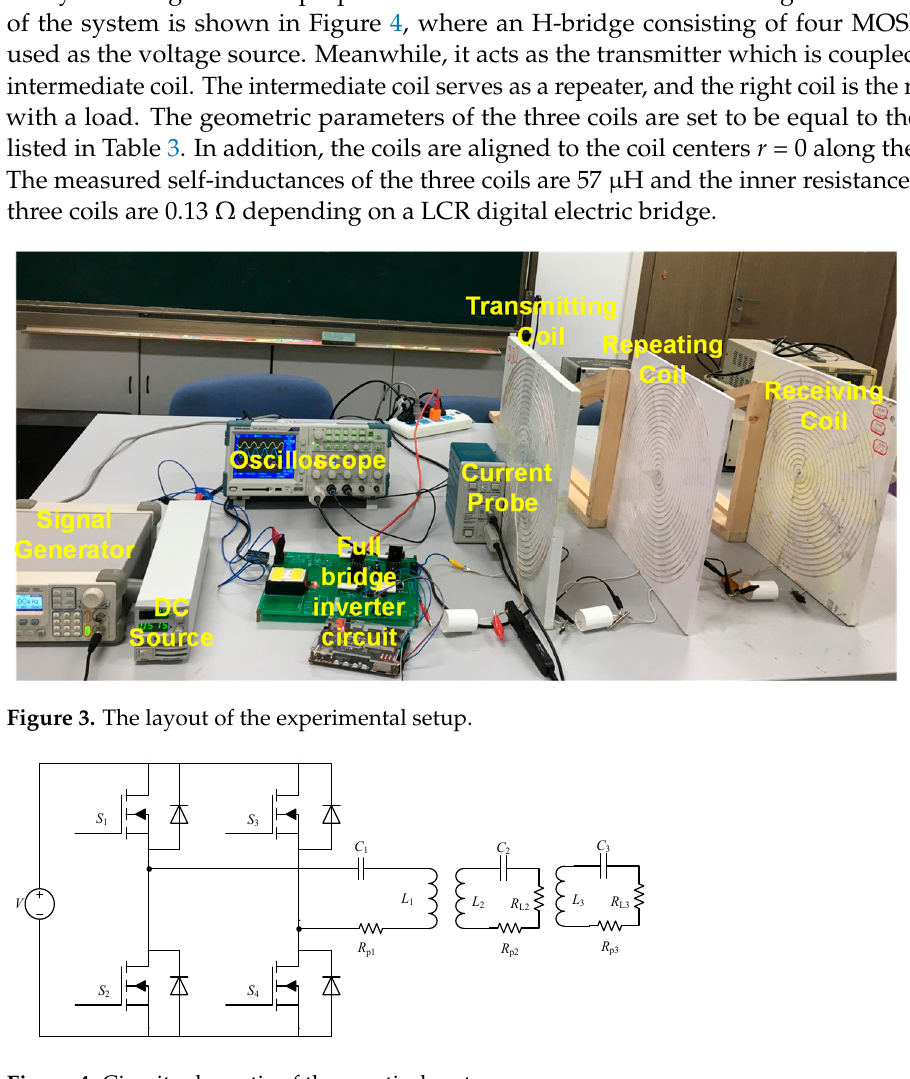
Figure 4. Circuit schematic of the practical system. Table 3. The Geometric Parameters of the Practical Coils.